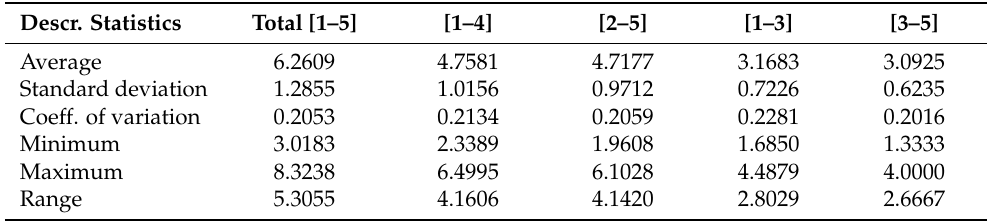
Table 13. The descriptive statistics of the mean PVI cumulative values across all cumulative ranges and pilot